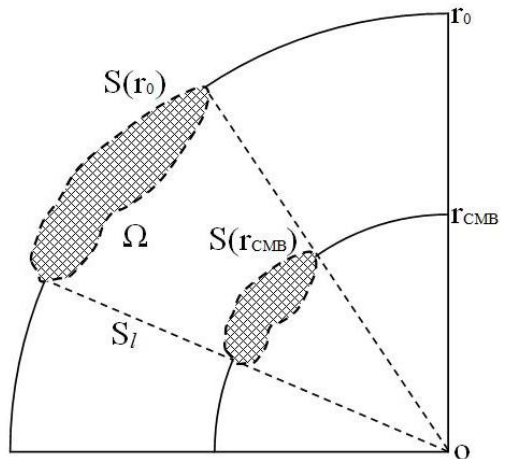
Fig. A1. The magnetic flux crossing both the core mantle bound- ary (CMB) and South Atlantic Anomaly (SAA) is conserved. Thus analyses on the SAA at the Earth surface are equivalent to those made at the